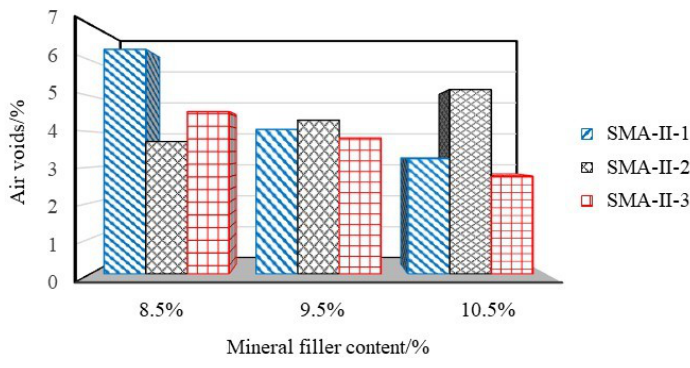
Figure 9. The influence of mineral filler content on air voids.